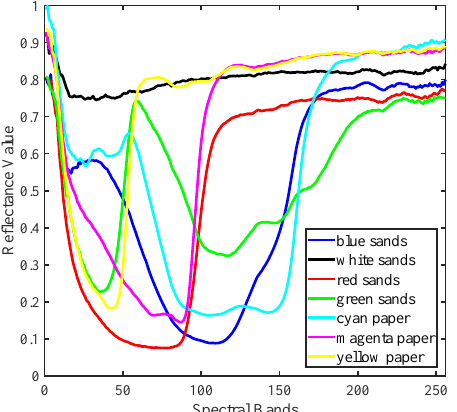
Figure 5. Spectral signatures of seven materials extracted from the dataset. They form the endmember matrix that is used in Section 4.2.